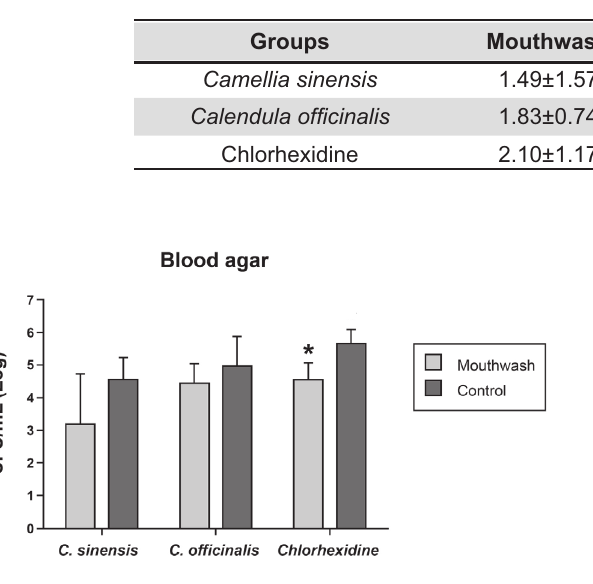
Table 1- Mean number and standard deviation of colony-forming units (CFU)/mL (log suture materials and grown on Mitis Salivarius bacitracin sucrose agar obtained for the control groups and groups using